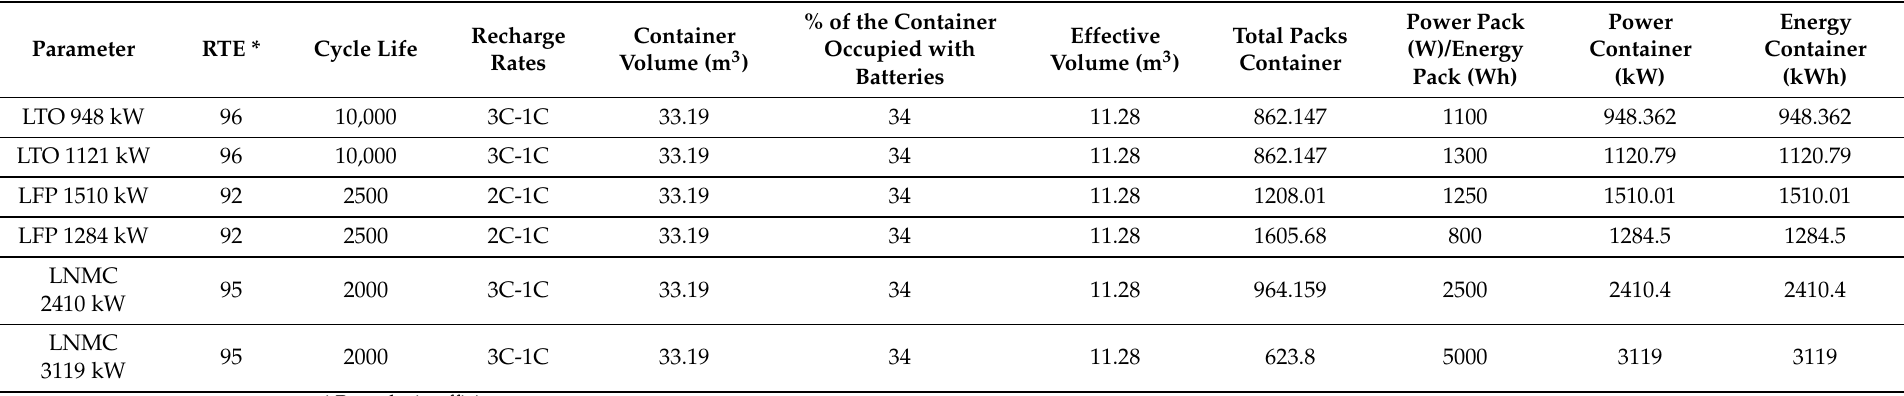
Table 4. Container of battery parameters.